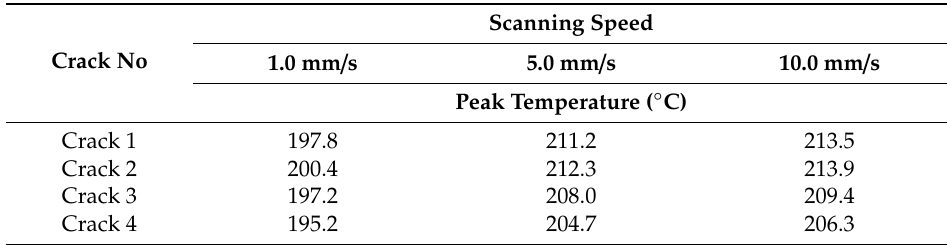
Table 3. Peak temperature variation for the di ff erent cracks at di ff erent scanning speeds (statistical positive